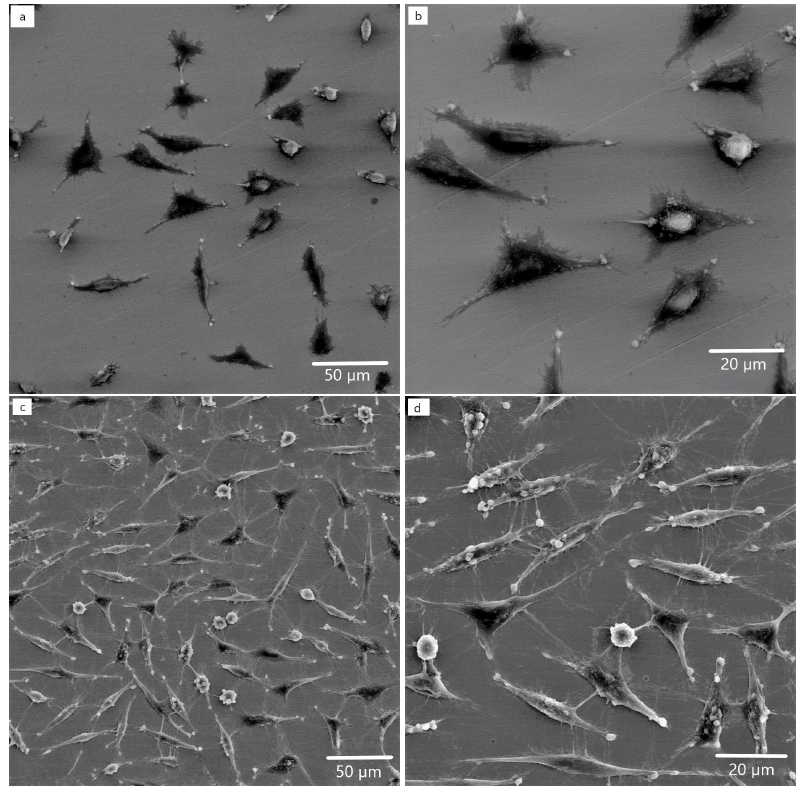
Figure 7. SEM images after cell growth test from 316L commercial sample ( a ) 1 day, × 500 and